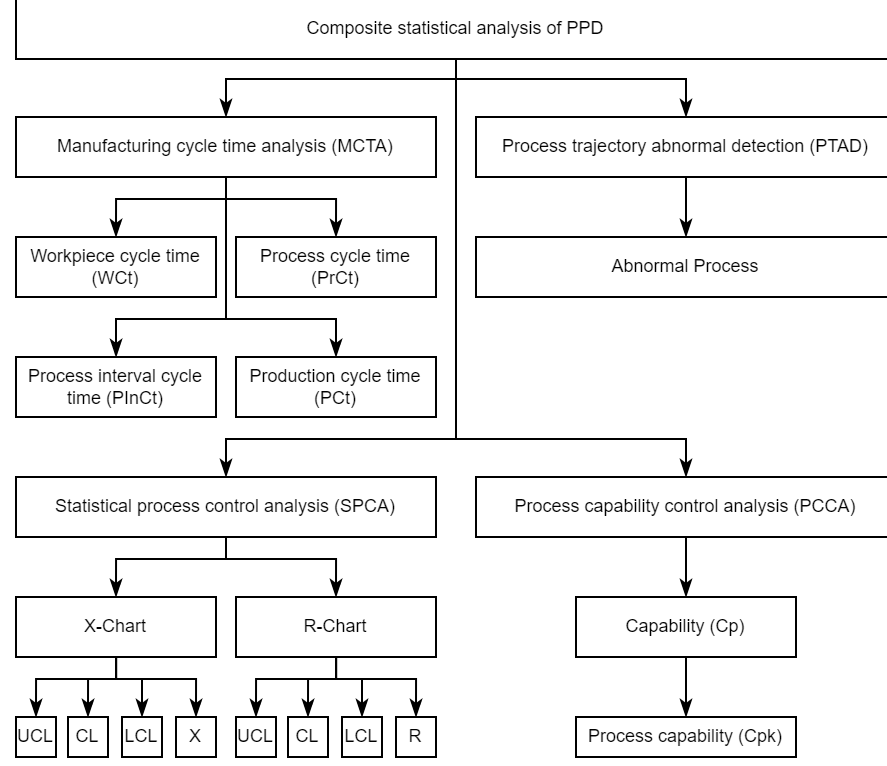
Figure 2. Composite statistical analysis of PPA.